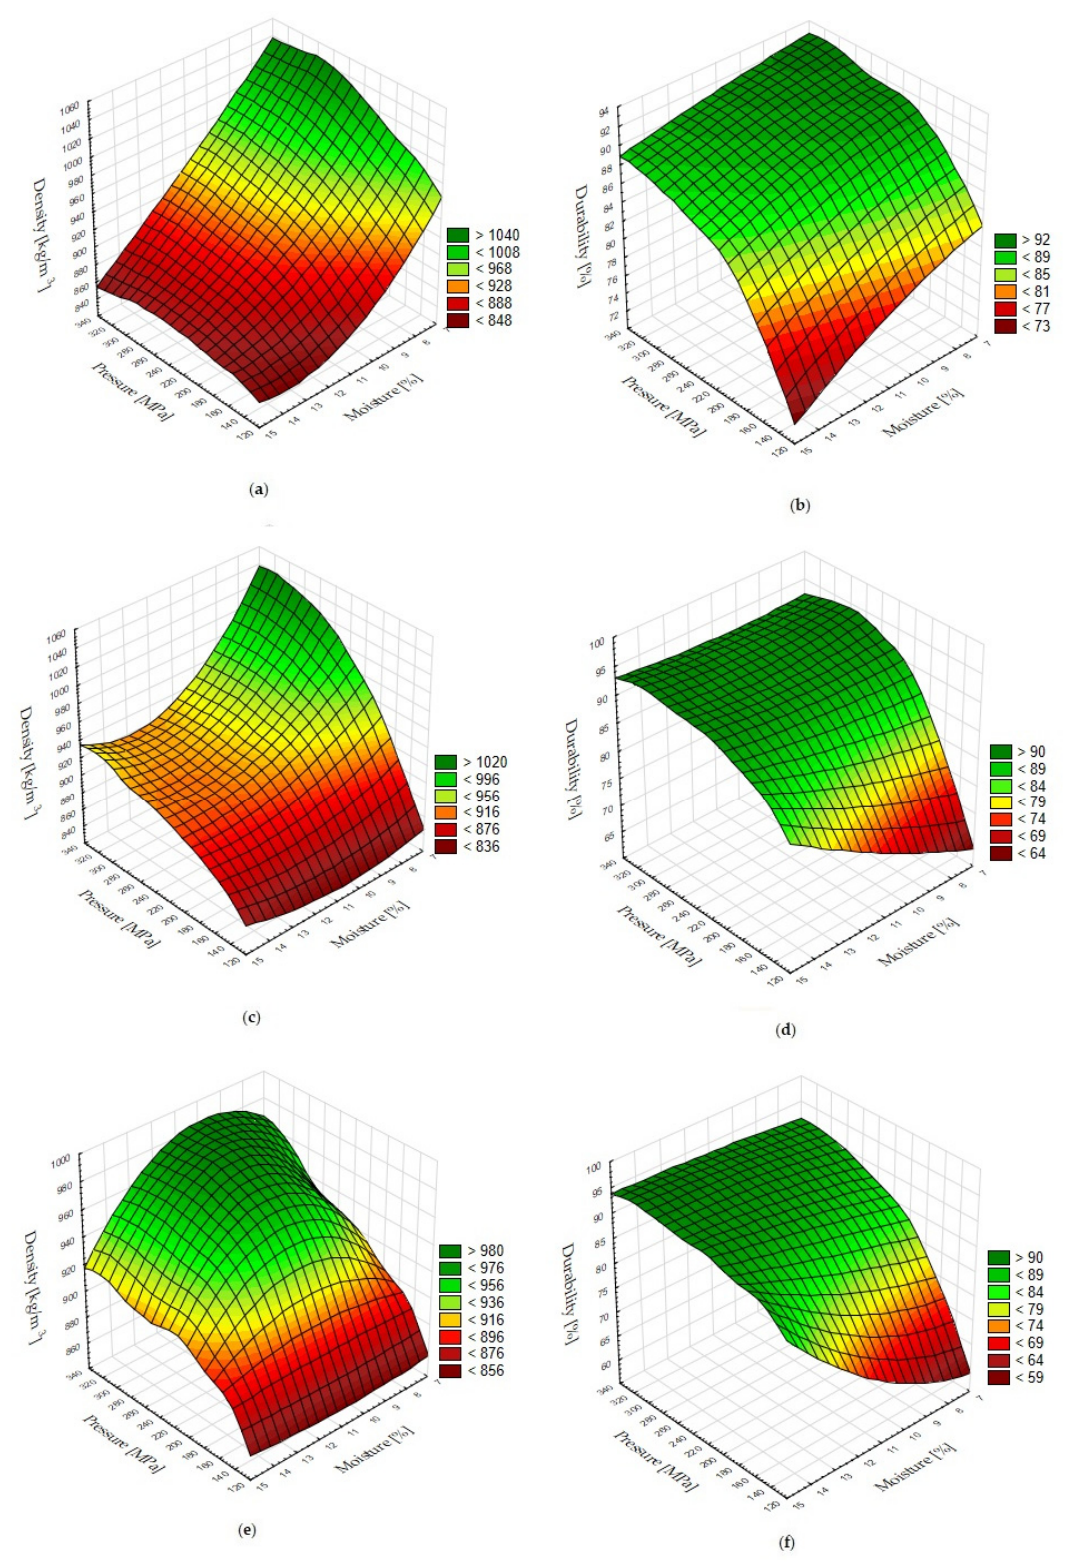
Figure 7. Influence of moisture and pressure on: ( a ) Miscanthus (solid density, DE), ( b ) Miscanthus (mechanical durability, DU), ( c ) Silphium DE, ( d ) Silphium DU, ( e ) Sida DE, ( f ) Sida DU.